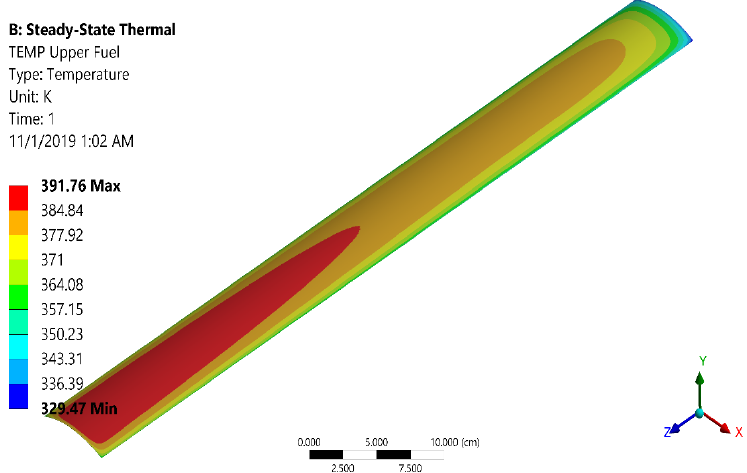
Figure 15. Temperature contours for the convex side of the fuel plate.